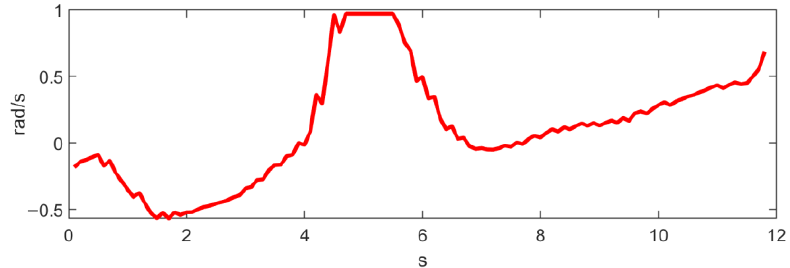
Figure 15. Angular velocity generated in the long wall scenario.